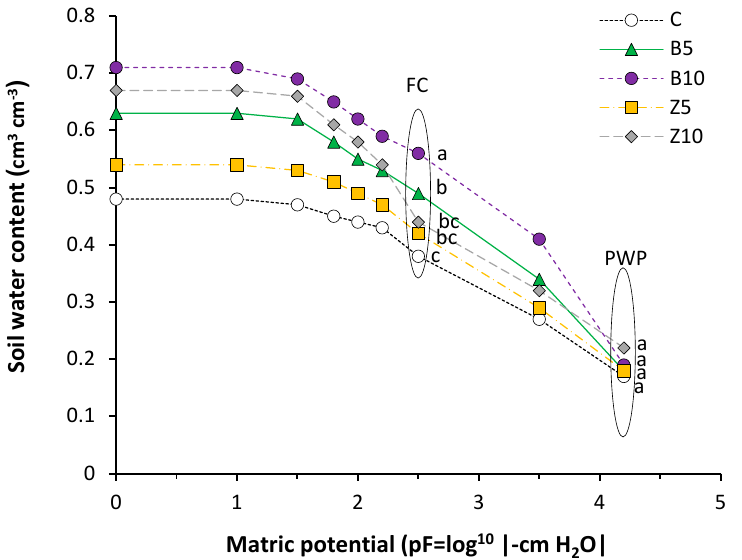
Figure 2. Effect of treatments on soil water retention curve. Different lowercase letters indicate significant differences between means ( p < 0.05).